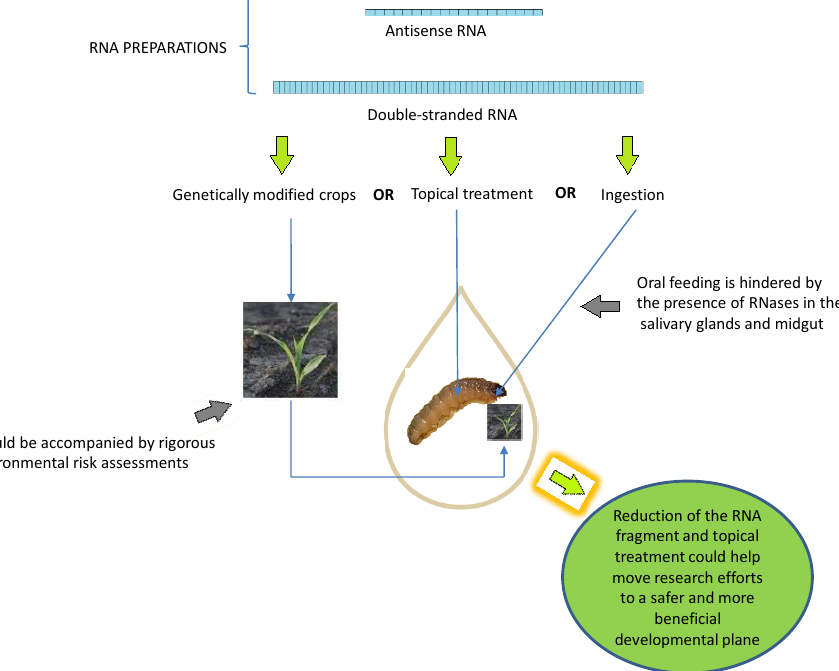
Figure 3. Perspectives of RNA preparations in agriculture.